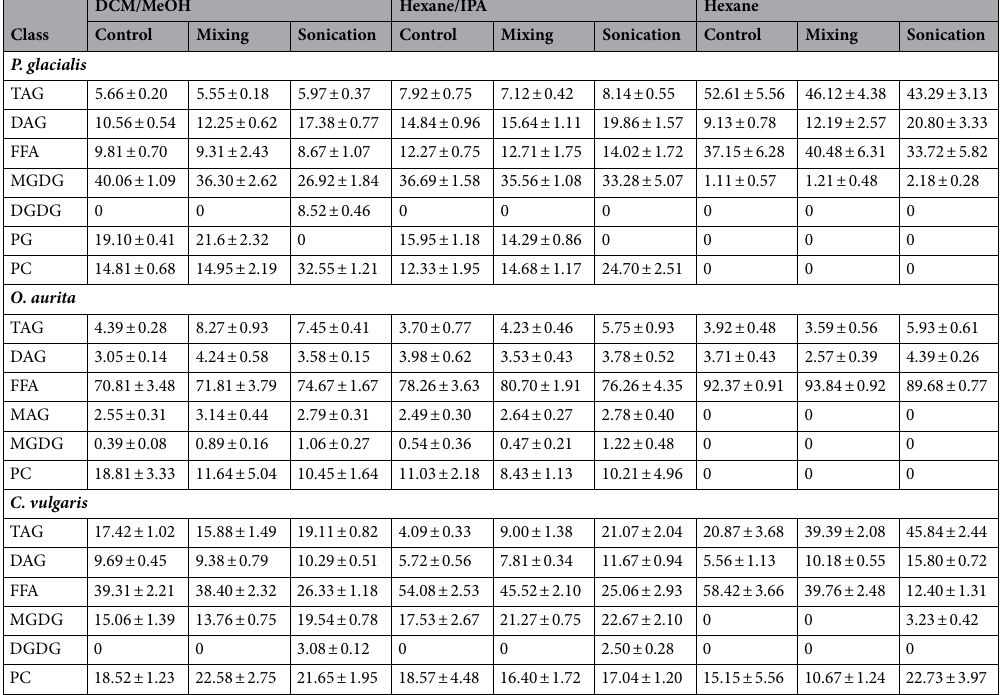
Table 1. The relative composition of lipid classes in extracts of Porosira glacialis , Odontella aurita and Chlorella vulgaris extracted with dichloromethane/methanol (2:1 v/v; DCM/MeOH), hexane/isopropanol (2:1 v/v; Hexane/IPA) and hexane, using three pre-treatments; no treatment (control), shaking at 1000 RPM for 60 min, (mixing), or sonication at 20 kHz for 10 min (sonication). Data shown is averages of replicates ± SD, n = 5. TAG triacylglycerol, DAG diacylglycerol, FFA free fatty acid, MAG monoacylglycerol, MGDG monogalactosyldiacylglycerol, DGDG digalactosyldiacylglycerol, PG phosphatidylglycerol, PC phosphatidylcholine.